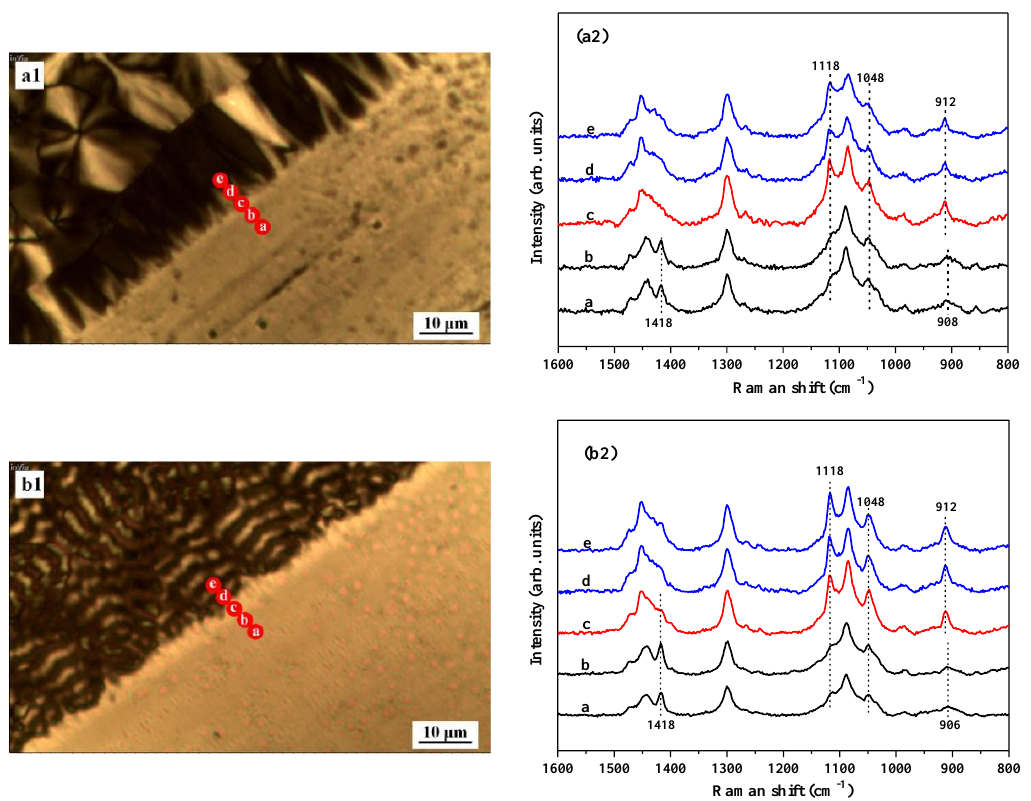
Figure 6. Raman spectra of PBA crystallized at ( a1 , a2 ) 25 °C and ( b1 , b2 ) 30 °C in the interfacial region from PBS to glass substrate.